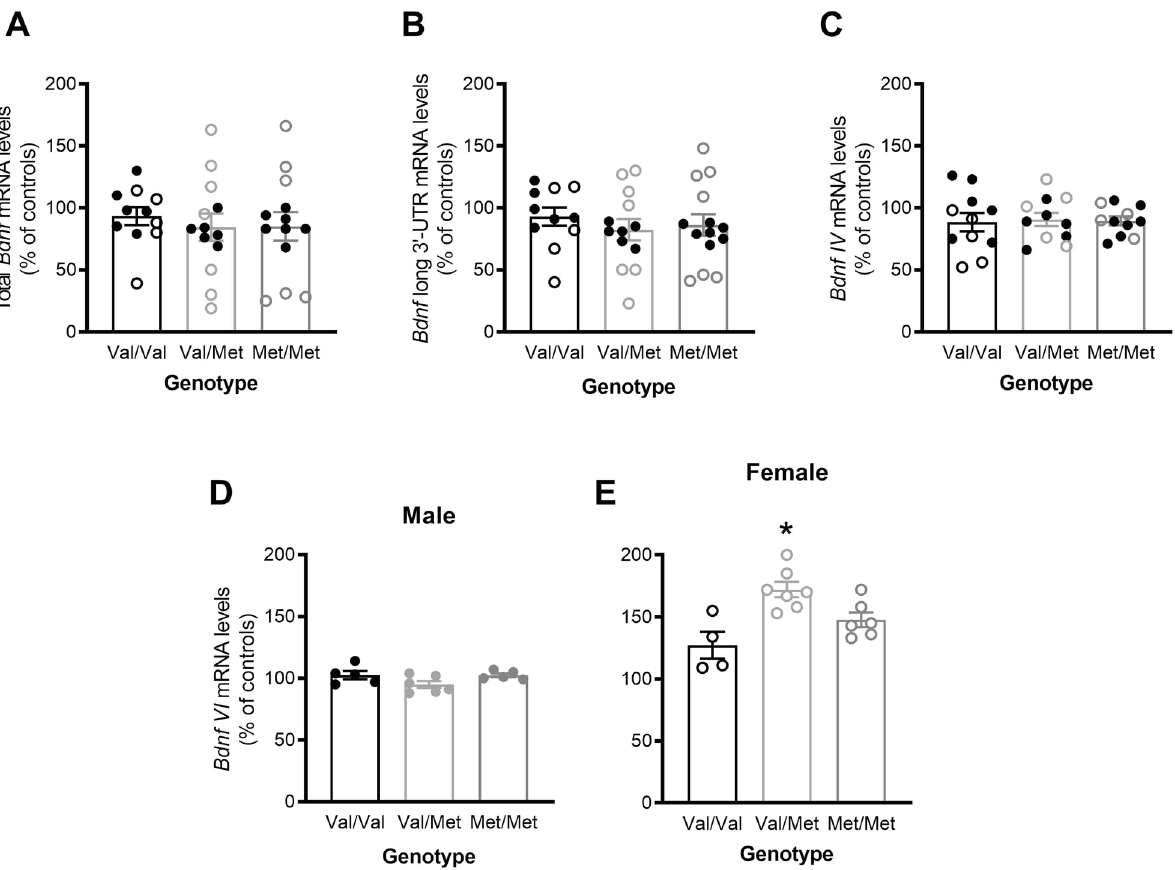
Fig. 4 BDNF gene expression in the dorsal hippocampus as measured by RT-qPCR. We measured BDNF total mRNA ( A ), BDNF long 3 ′ UTR ( B ), BDNF exon IV ( C ) and BDNF exon VI ( D , E ) mRNA. Female Val/Met rats showed higher BDNF VI expression than Val/Val controls. Data are presented as % of controls (Male Val/Val rats) showing mean ± SEM of sexes combined with individual data points for all rats (males closed symbols, females open symbols). * p < 0.05 compared to Val/Val Analysis of time spent in the novel arm of the Y-maze compared to the average of the two familiar arms (Fig. 3F) showed a large main effect of arm ( F (1,63) = 99.2, p < 0.001, η p 2 = 0.61) indicating